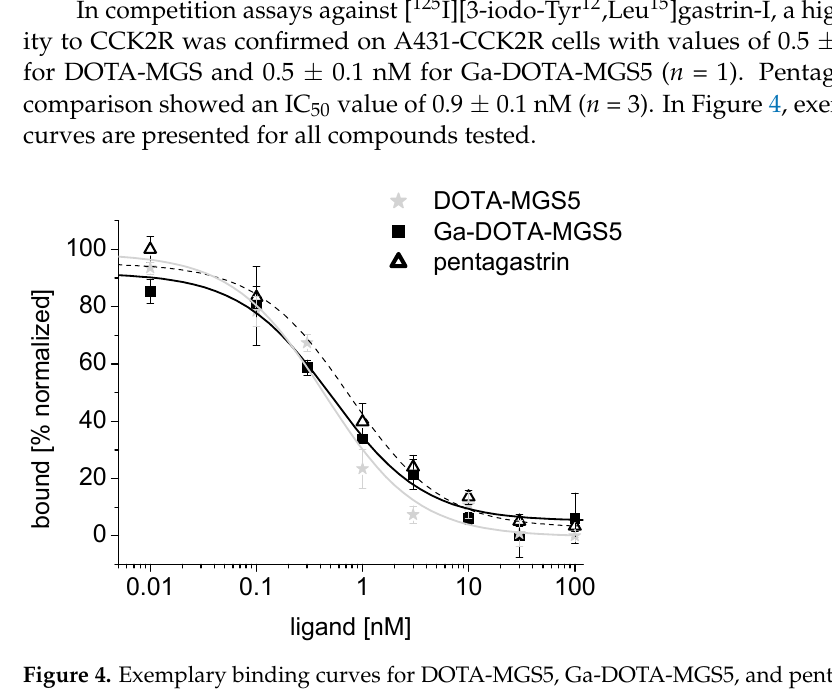
Figure 4. Exemplary binding curves for DOTA-MGS5, Ga-DOTA-MGS5, and pentagastrin.